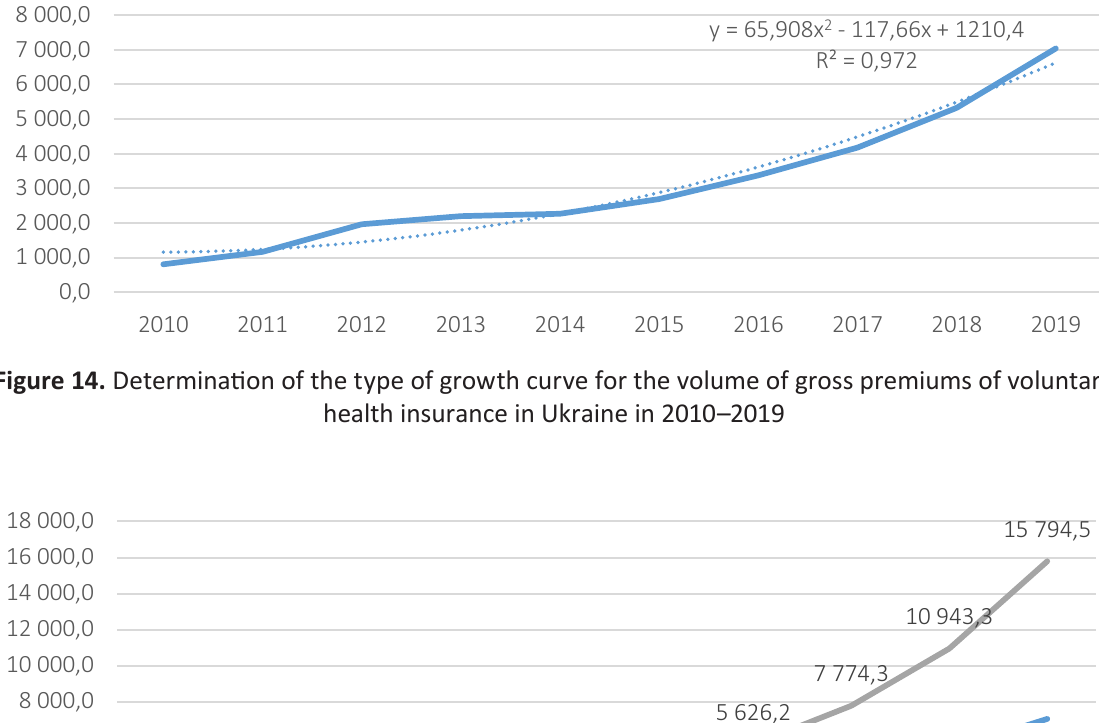
y = 65,908x 2 - 117,66x + 1210,4 R² = 0,972